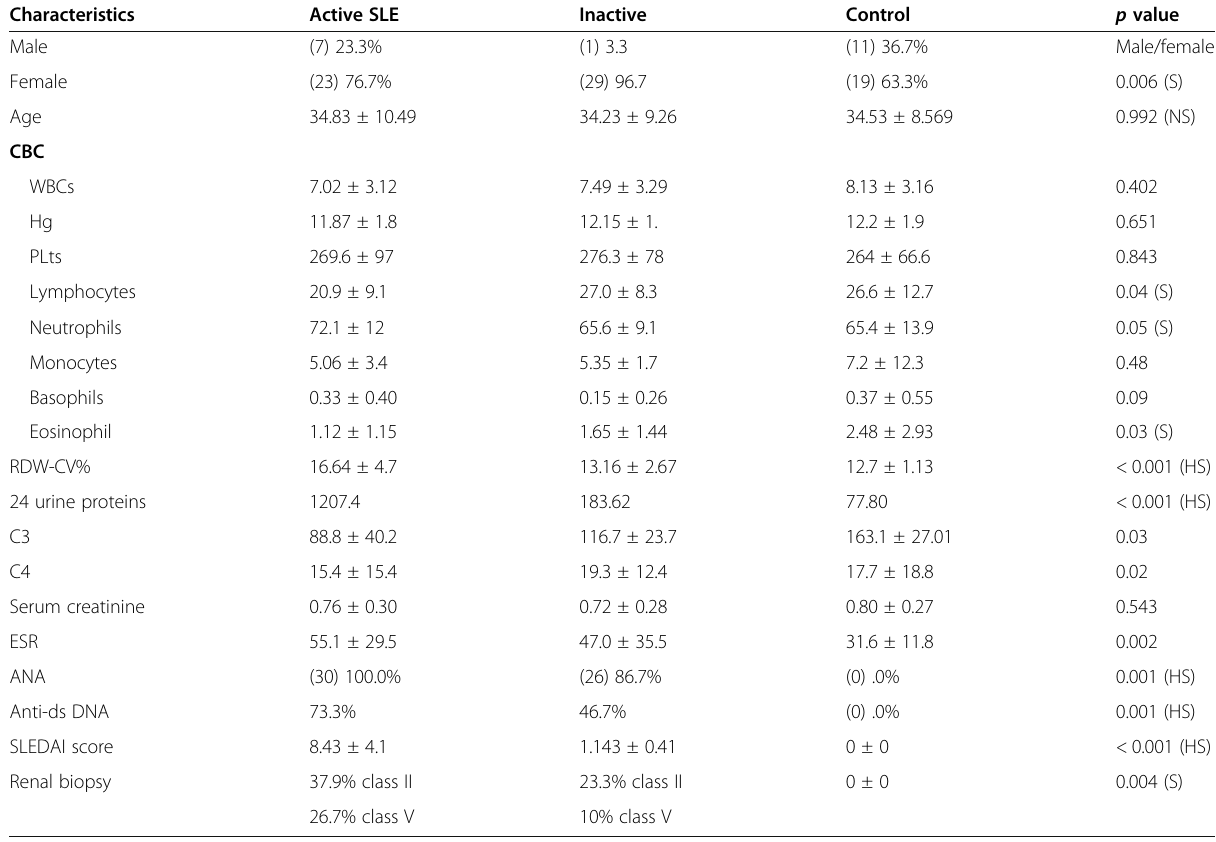
Table 2 Comparison between the studied groups regarding sex and age distribution, laboratory parameters, and disease activity score